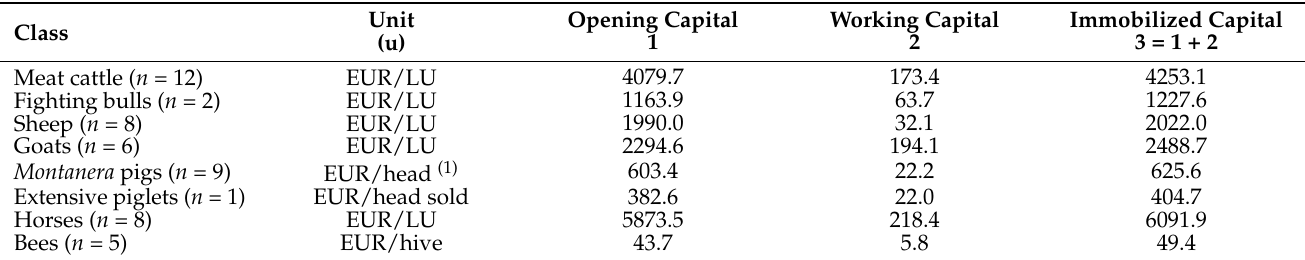
Table 6. Livestock species immobilized capital for large privately owned case-study dehesas in Andalusia (2010: EUR/u). Class